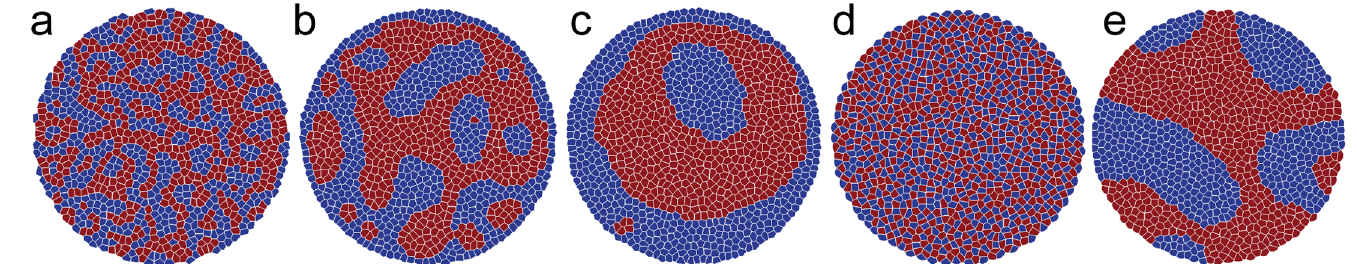
Fig 9. (a-c) Snapshots of a system of two cell types at times 10, 500 and 5000with Λ rb = − 6.4. (d) A “checkerboard” pattern formes immediately (at time 10) when red-bluecell-cellcontacts are energetically favourable compared with pairs of red-redand blue-bluecontacts, Λ rb = − 6.7. (e) Same initial system as (a-c) but with red-boundary contacts slightly favoured over blue-boundary contacts. The system graduallyseparatesinto compartmentsof each cell type. The uncorrelated random fluctuations are sufficient to drive neighbourexchangeswithin the bulk of both the red and blue cell compartments. Cells on the compartment boundarycan sometimes move parallelto it but meet strong resistancewhen trying to move across it.